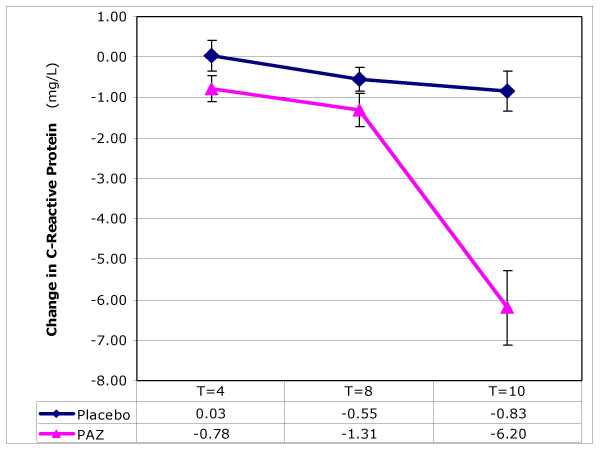
The effect of ProAlgaZyme vs. placebo on C-reactive protein (mg/L). Values are mean change at 4, 8 and 10 weeks compared to baseline within 95% confidence limits (+/- 1.96*(standard error of the mean)).